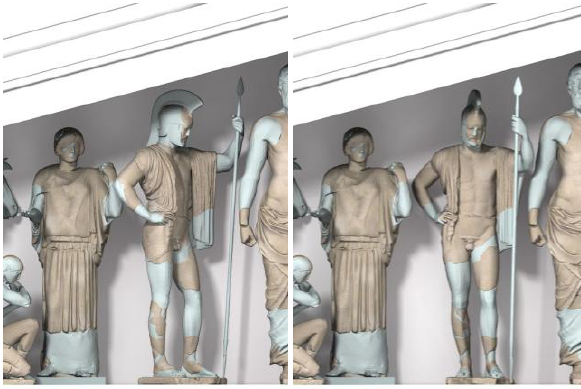
Figure 8. The same arrangement (closed “A”) with figure I turned away from the rear wall (left) and parallel to it (right).